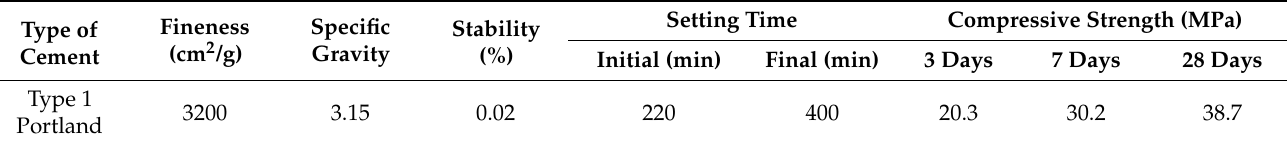
Table 1. Properties of the cement.